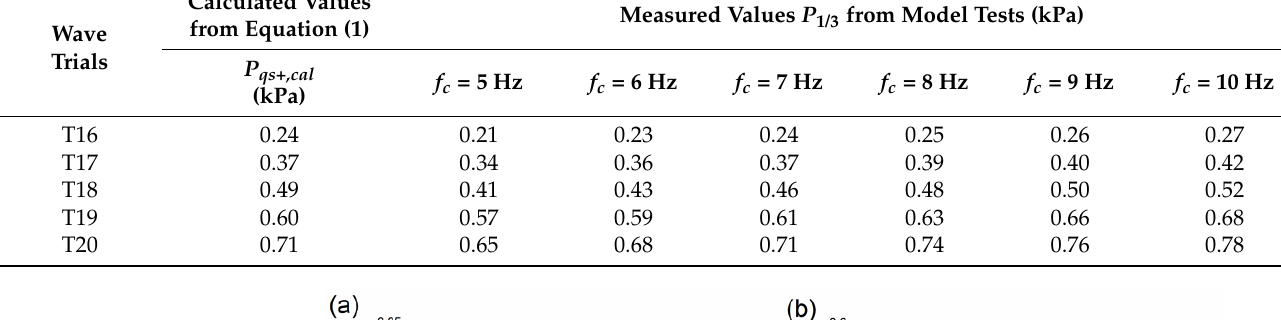
Table 4. Comparison between calculated and measured results.